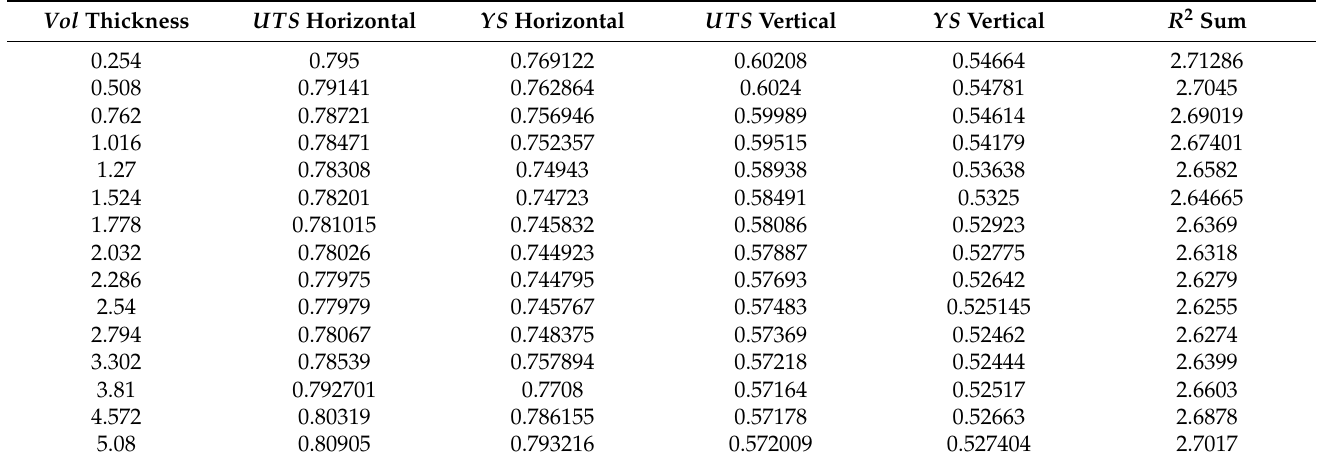
Table 9. R 2 values for predicted UTS and YS for the horizontal and vertical components utilizing a range of values for the volume in the z , or vertical, direction in order to optimize the accuracy of the predicted results for all components of the stresses.